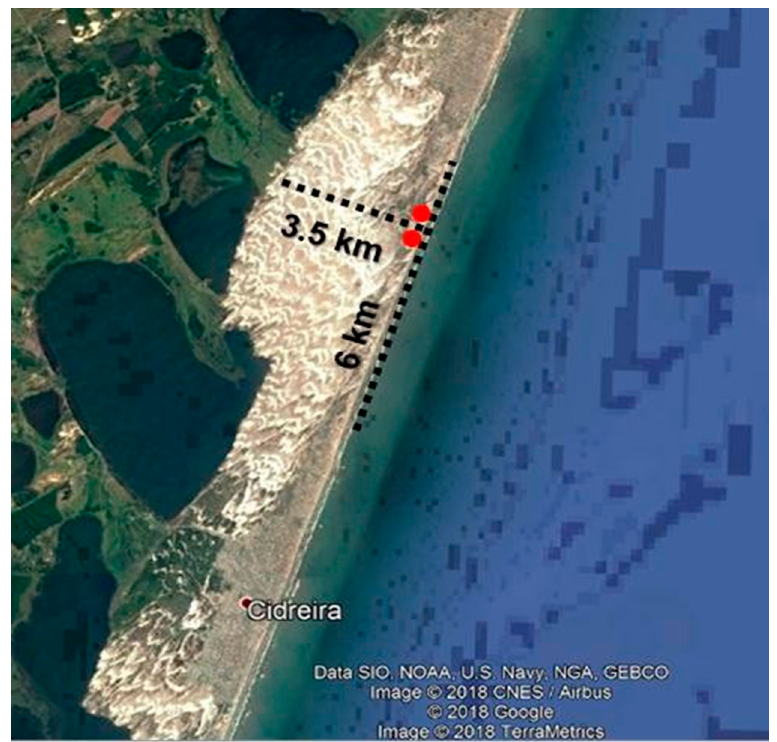
Figure 2. Dune field (Cidreira beach) location showing its distance from urbanized areas (Google Earth, 2017). Red dots = sampling points.